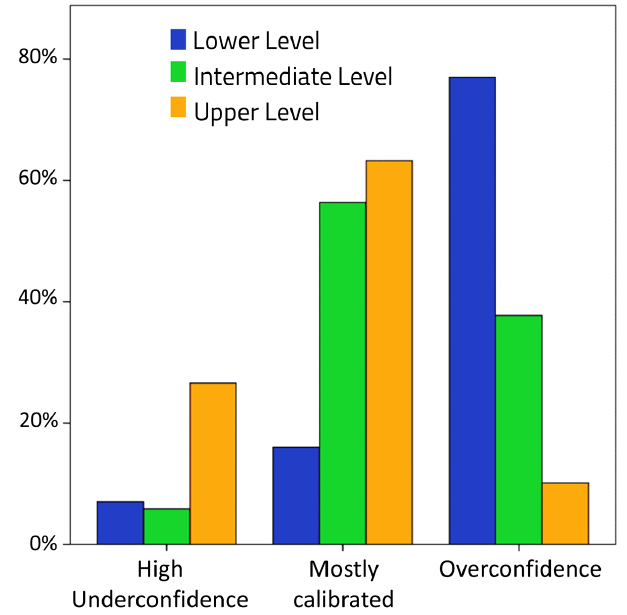
FIG. 10. Distribution of all respondents across the three confidence levels, subdivided according to the levels of the construct map in QM (see Appendix for definition of the construct map levels and Table II for confidence